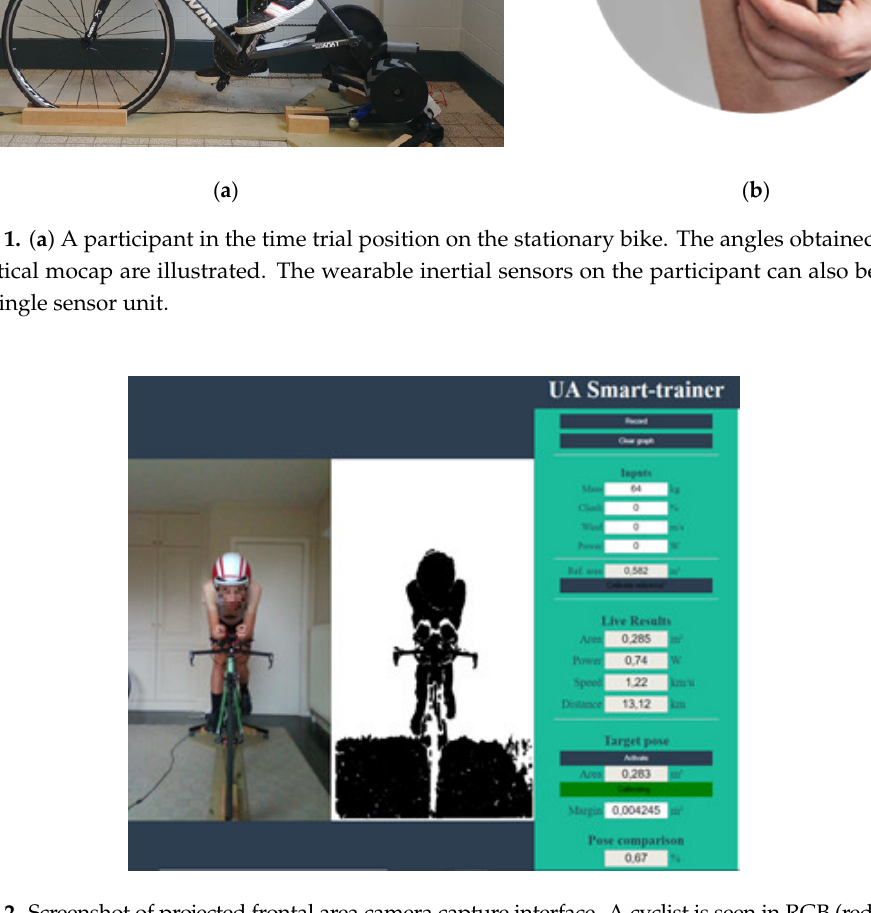
Figure 2. Screenshot of projected frontal area camera capture interface. A cyclist is seen in RGB (red green blue) picture format and their projected area is shown as a silhouette. A calibration step is required to eliminate the floor from the projected frontal area calculation. The area in m 2 is also present in the interface and is recorded at 3 Hz.